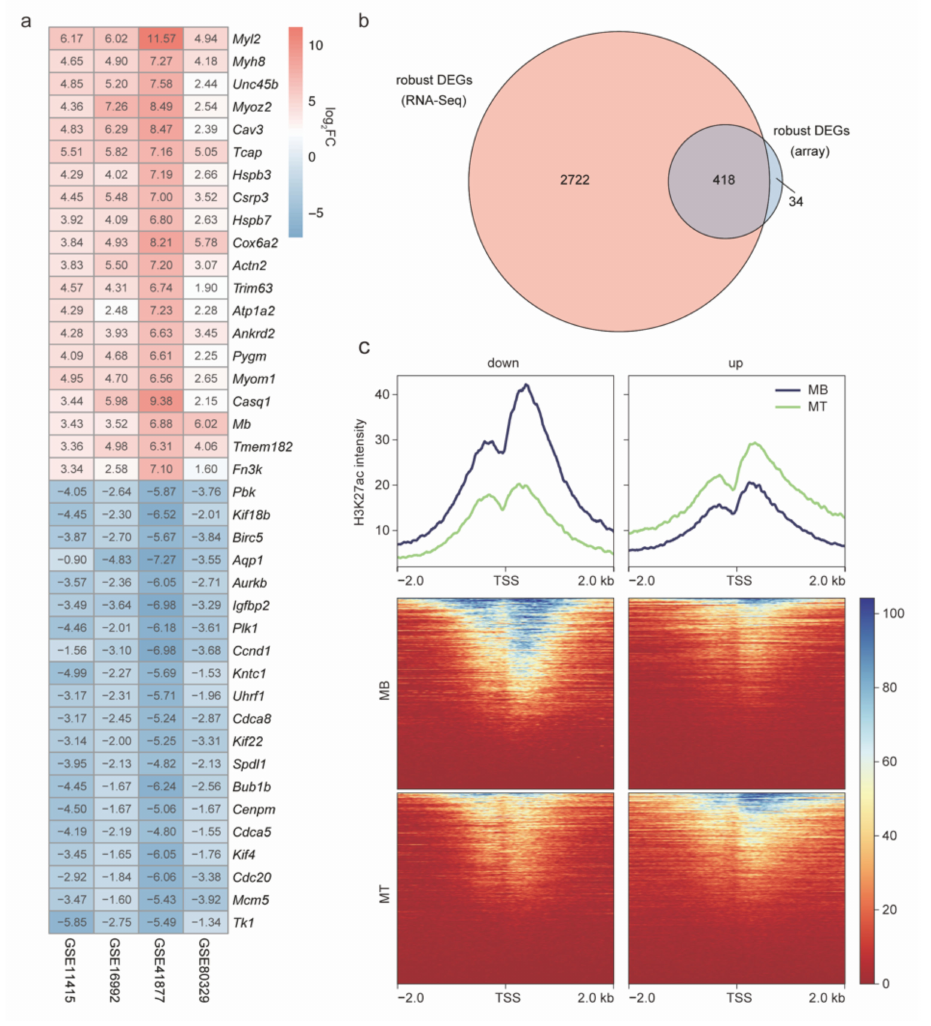
Figure 4. Reliability analysis of robust DEGs. ( a ) Top 20 up- and downregulated robust DEGs across 4 array expression datasets during C2C12 cell myogenesis. The log 2 FC (log 2 fold change) represent gene expression change. ( b ) The overlap of robust DEGs identified using RNA-Seq datasets and array expression datasets. ( c ) H3K27ac signal levels in the TSSs of up- and downregulated robust DEGs in C2C12 MBs and MTs. The H3K27ac intensity represents read intensity from H3K27ac ChIP-Seq